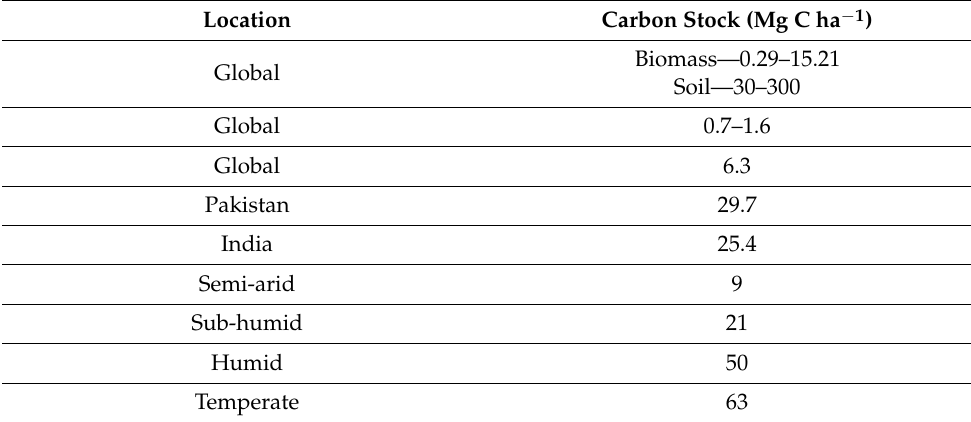
Table 4. Reported carbon stocks in agroforestry systems. Source: